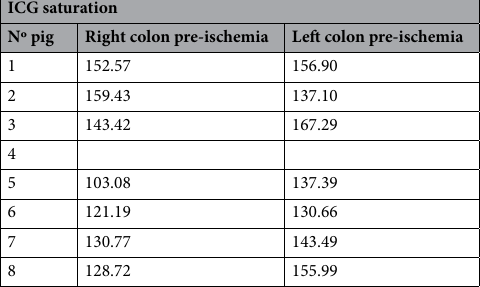
ICG saturation Nº pig Right colon pre-ischemia Left colon